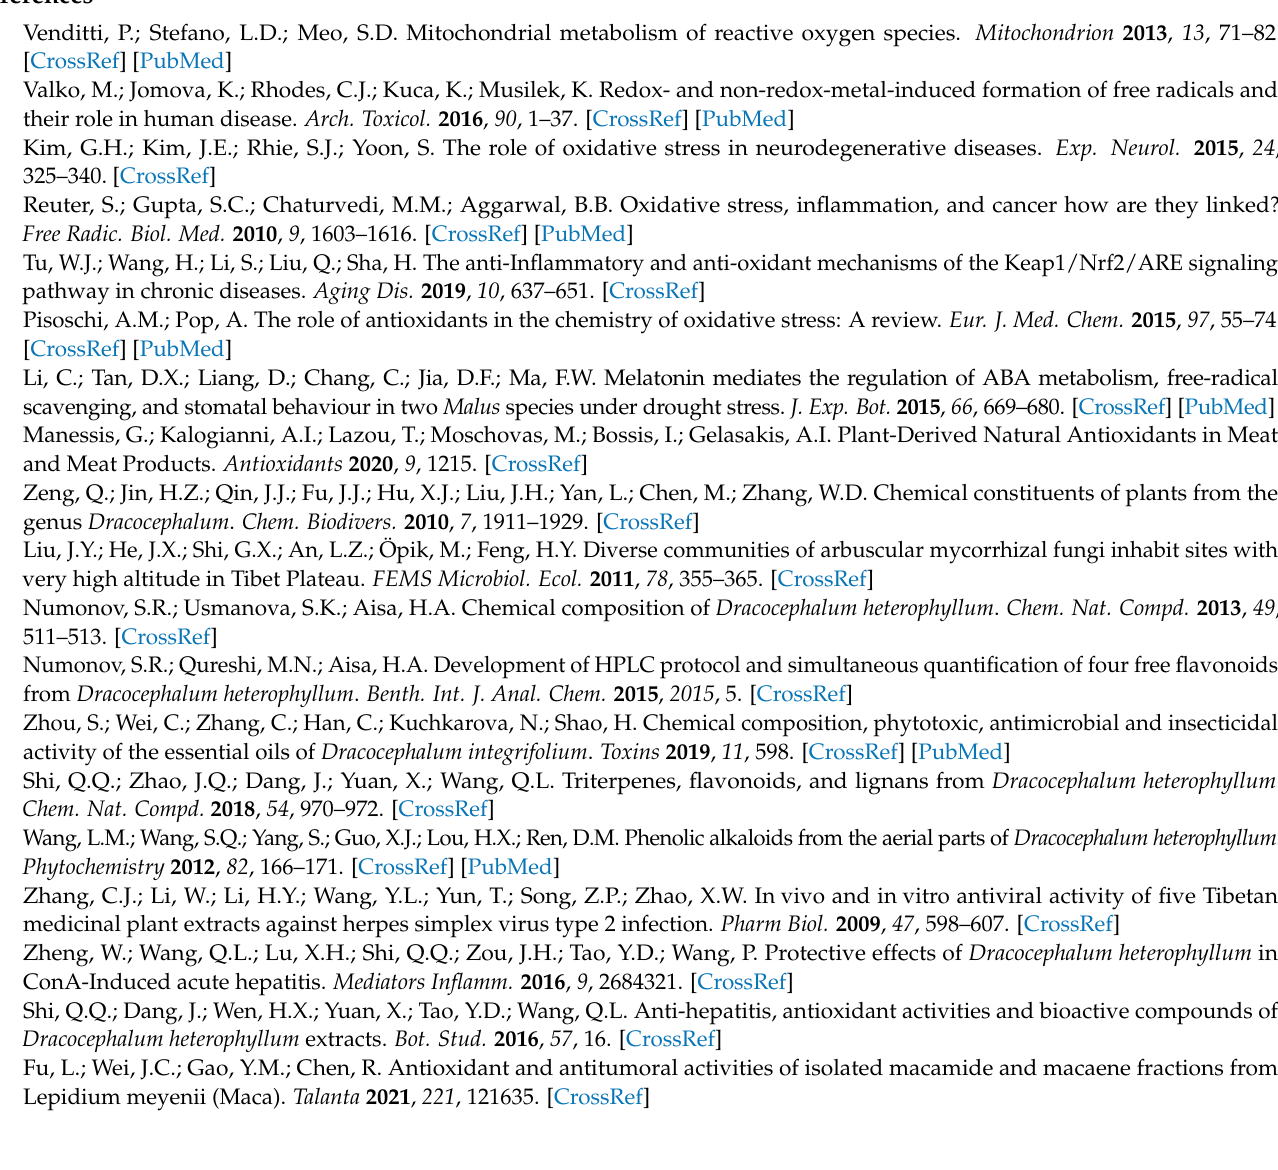
Figure S15: The actual HPLC–DPPH system. Figure S16. The actual high-pressure liquid chromatography